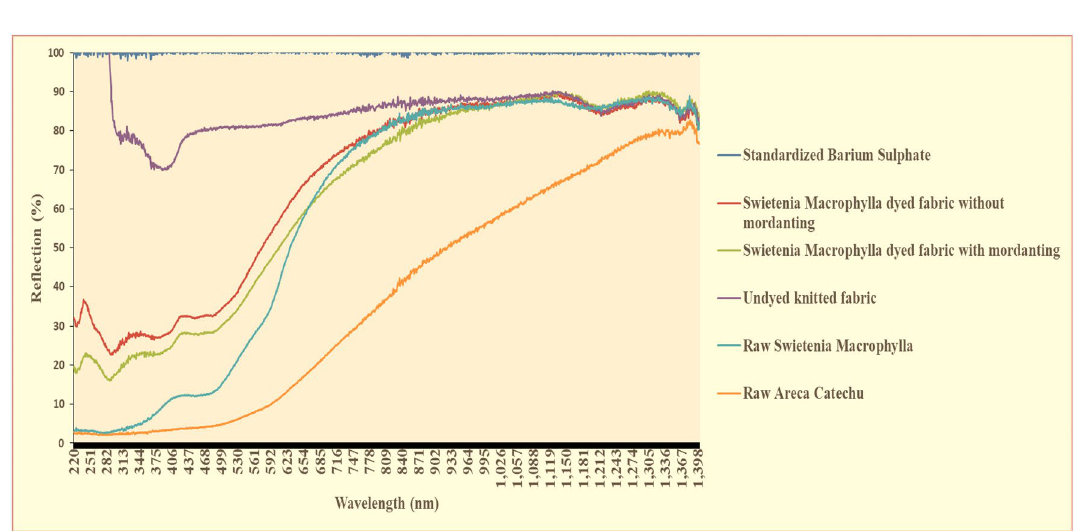
Figure 5. UV–Vis–NIR reflection spectra of undyed cotton fabric, dyed cotton fabric and NPND raw materials of woodland CB against standardized barium